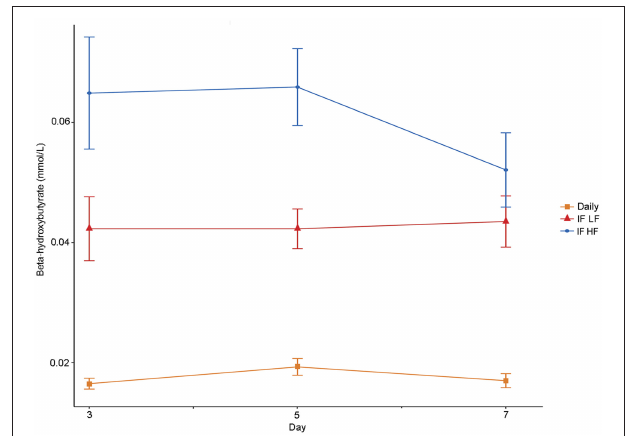
FIGURE 3 | Orthogonal partial least square with discriminant analysis (OPLS-DA) plot illustrating the effect of three feeding regime on the plasma metabolome of 10 dogs. Each point represents a single sample with the blue circles representing a dog intermittently fasted on a high fat diet, the red triangles representing a dog intermittently fasted on a low fat diet, and the orange squares representing a dog fed daily on a low fat diet. food per kgBWT 0.75 than female dogs (mean 277 ± 67 vs.